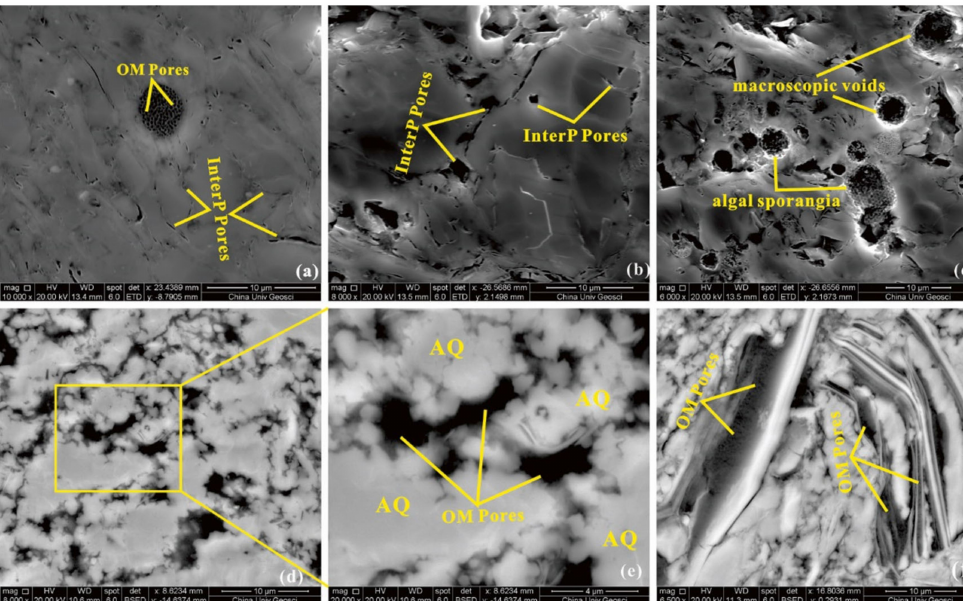
Figure 6. Pore structure characteristics of siliceous shale in Niutitang Formation. ( a – c ) pores in siliceous shale from GCC section, which show interparticle pores are the main pore type; ( d – f ) pores in siliceous shale from YWT section.